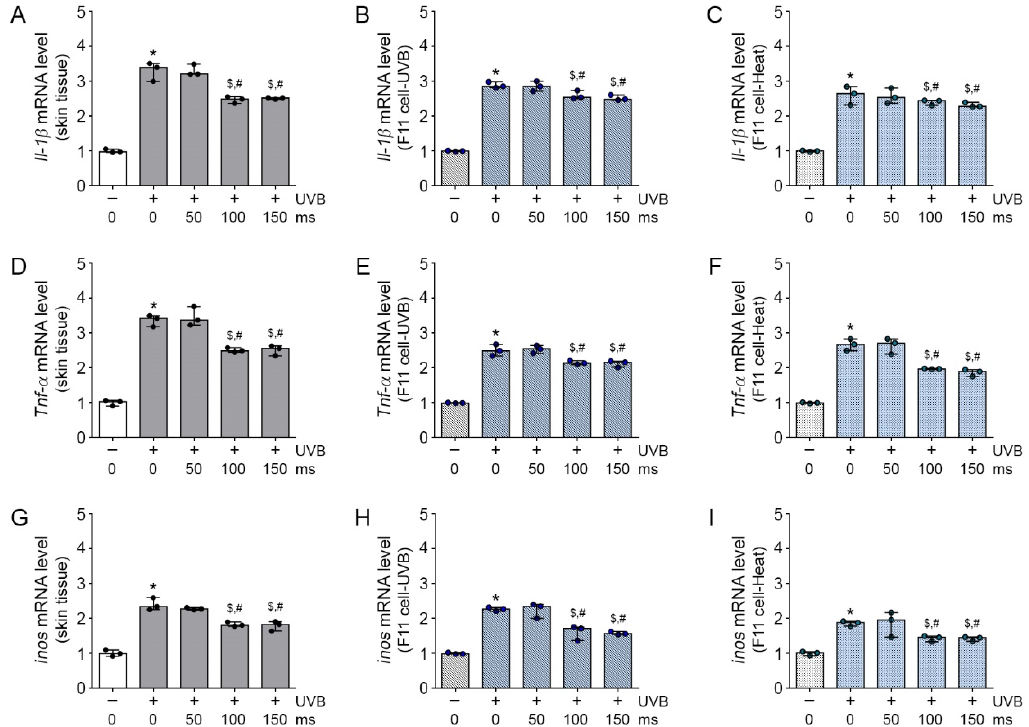
Figure 4. Attenuated effects of RF on neuropeptide-induced inflammation in UVB-exposed mice skin and UVB- or heat-treated sensory neuronal cells. ( A – I ) The neuropeptide-induced inflammation cytokine ( Il-1 β , Tnf- α , and inos ) mRNA expression level was analyzed by qRT-PCR in the skin tissue ( A , D , G ) (3 mice per group), UVB-CM-treated Raw264.7 cell model ( B , E , H ) and heat-CM treated Raw264.7 cell model ( C , F , I ) and were normalized to that of Actb and expressed relative to the control group. * p < 0.05 vs. Control; $ p < 0.05 vs. UVB-CM or Heat-CM; # p < 0.05 vs. RF 50 ms.